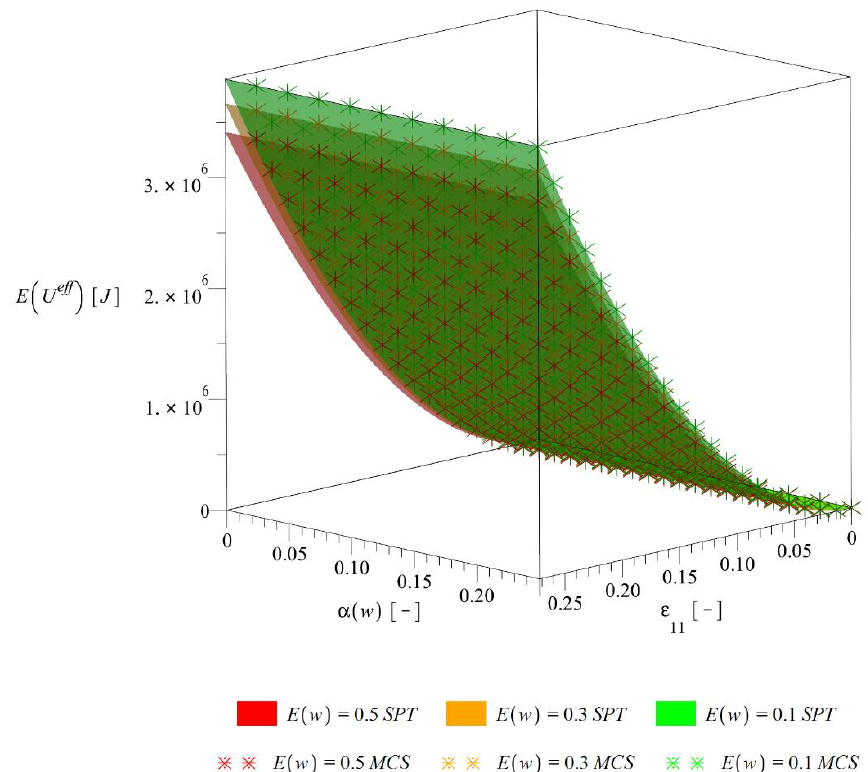
(cid:16) (cid:17) U ef f